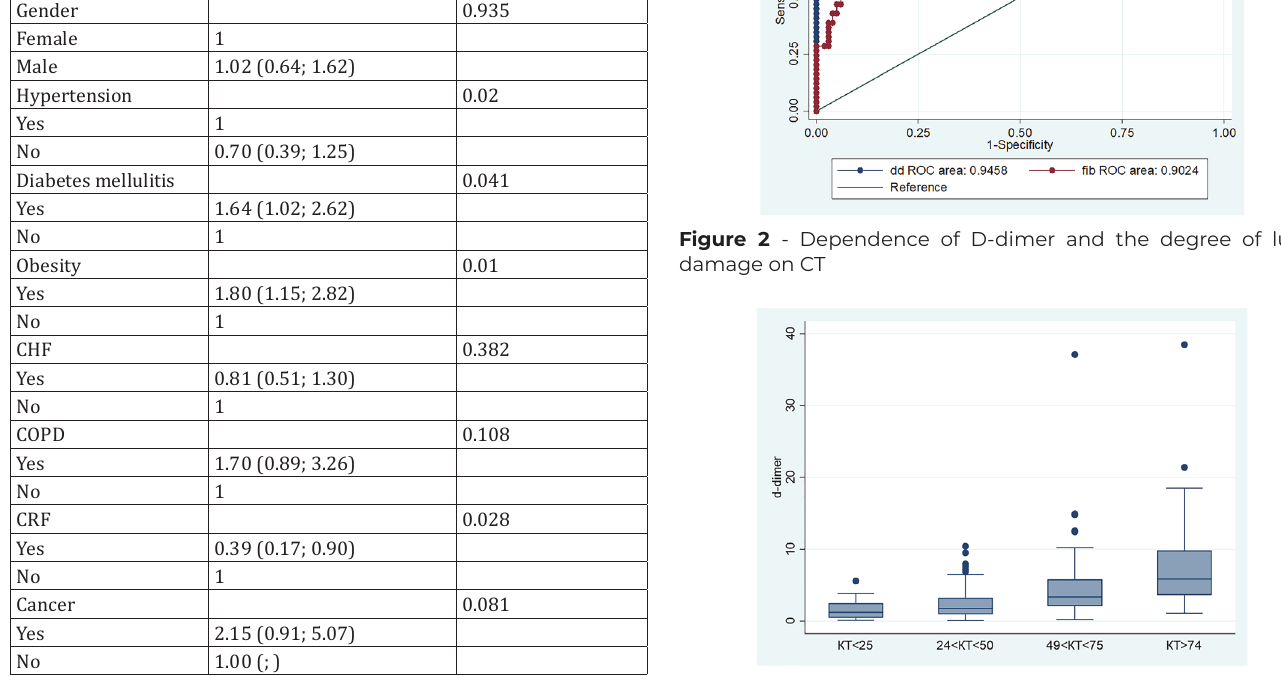
Figure 3 - ROC analysis for statistically significant variable (D-dimer, Fibrinogen Studies to identify venous thromboembolic complications. 2021 meta-analysis